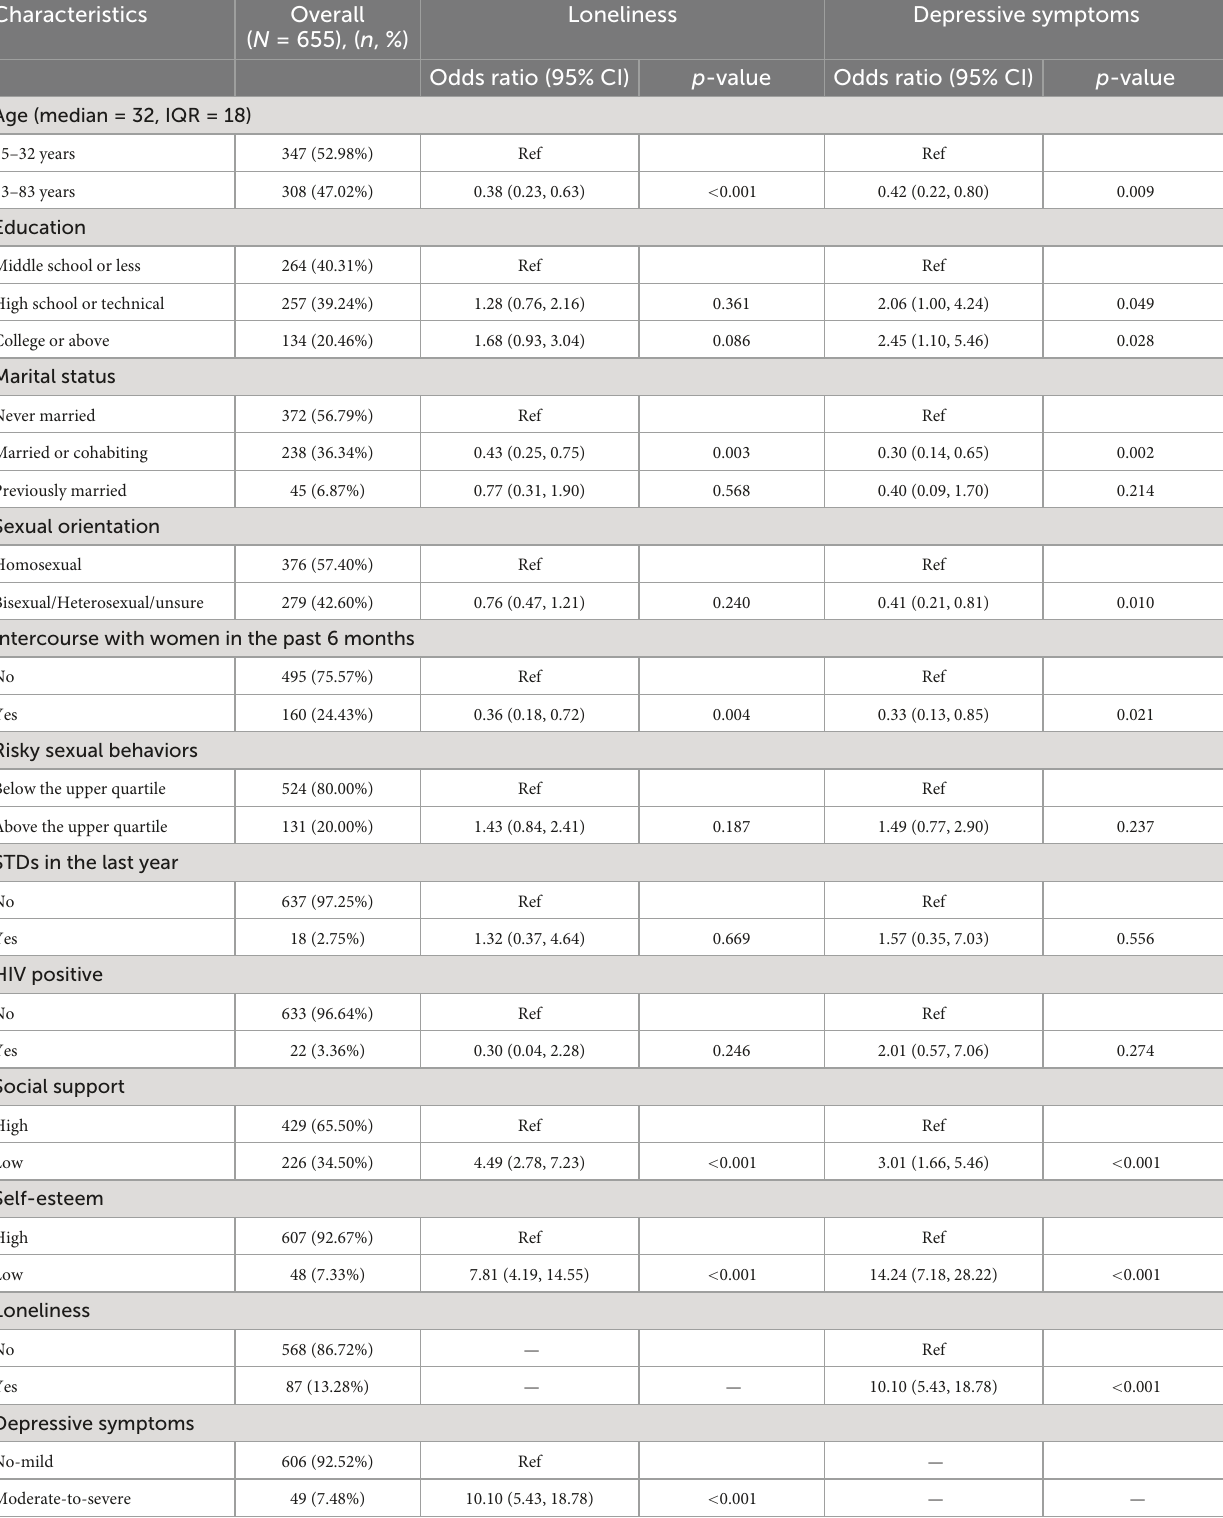
TABLE 1 Characteristics of the study sample and factors related to loneliness and depressive symptoms. Characteristics Overall ( N = 655), ( n , %)